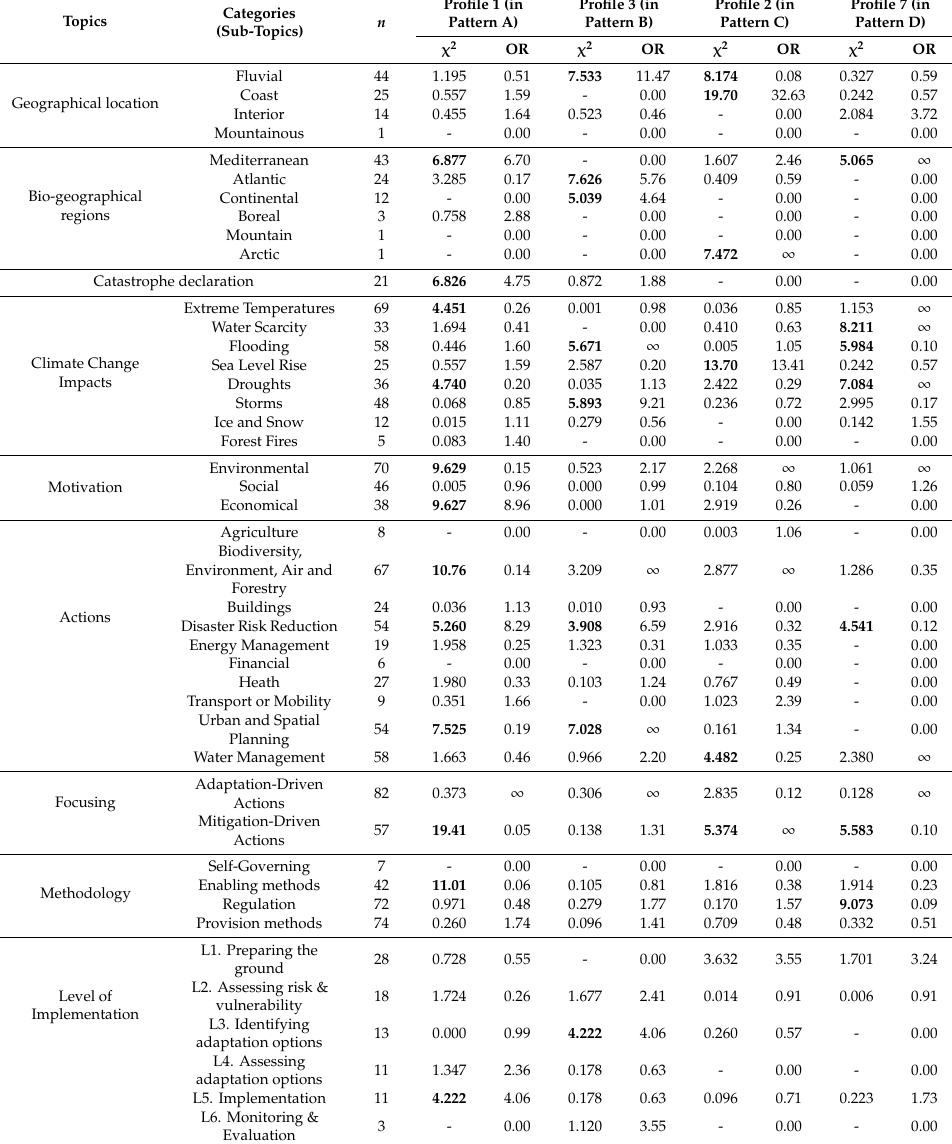
Figure 8. Distribution of the initiatives according to the vulnerable sectors facing climate change in the different biogeographical regions for each one of the four patterns. Source: Compiled by the authors. Table 3. Synthesis of the 19 profiles obtained. The dominant profiles (1, 3, 2, 7) are shown for each of the patterns obtained (A, B, C, D). Source: Compiled by the authors. N = 84; n = subsample; χ 2 = Chi Square Test; OR = odds ratio. Bold = Statistical Significance ( p -value ≤